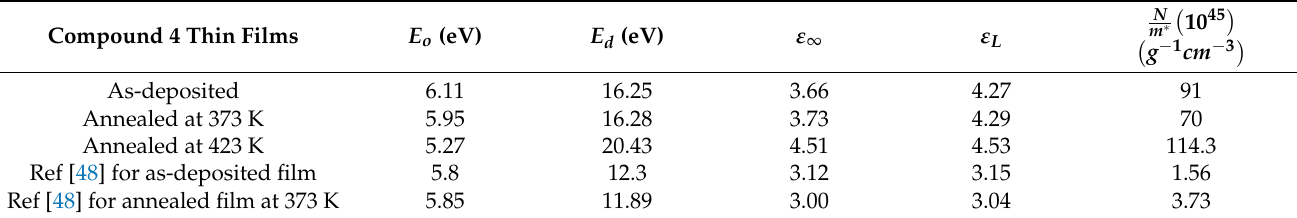
Figure 18. Plot of n 2 versus λ 2 for compound 4 organic thin films. Table 2. Optical dispersion parameters of compound 4 thin films.